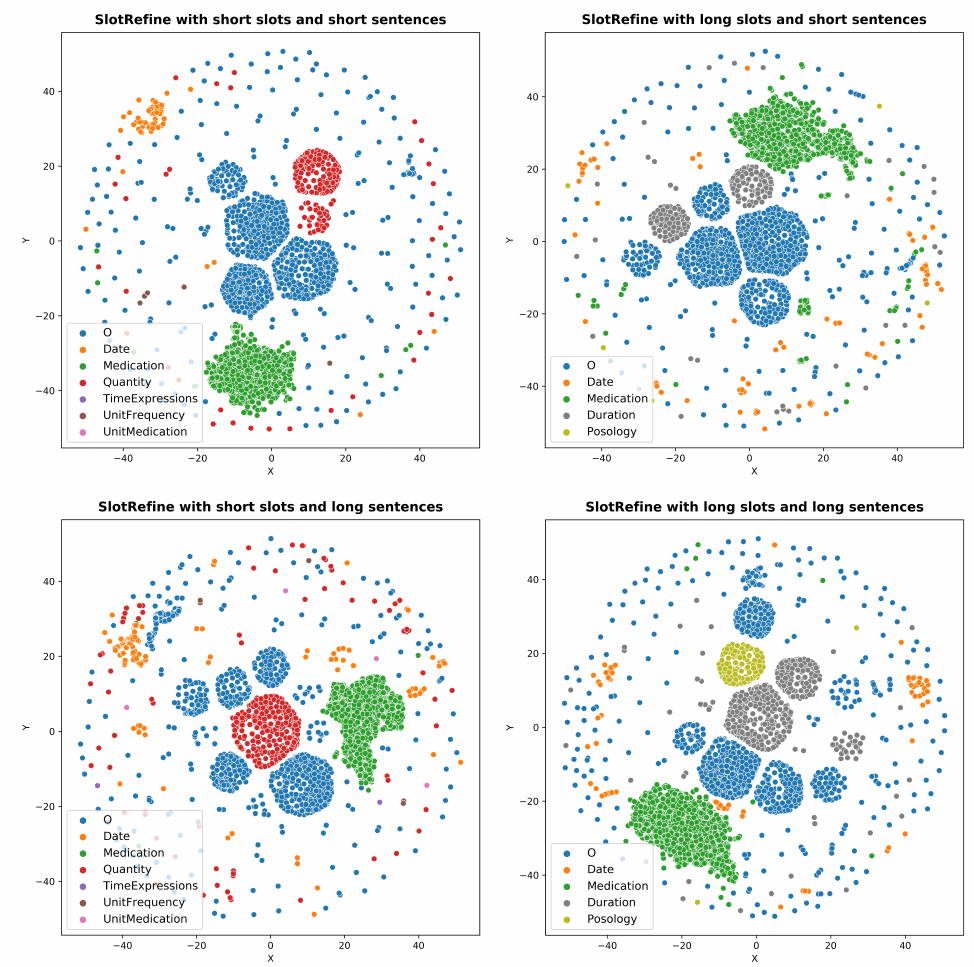
Figure 5. t-SNE representations for the best models for short/long slots and shot/long